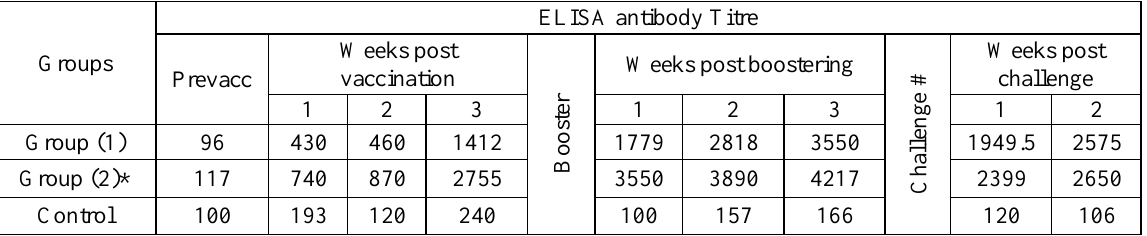
Table 3: ELISA titer in sera of vaccinated turkey poults using O1 antigen and challenged with E.coli serotype